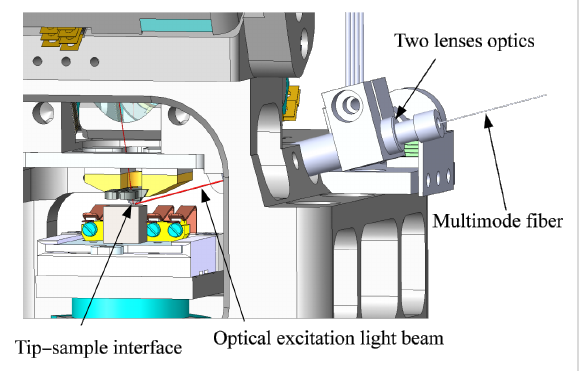
Figure 2: Additional two lenses optics which allows for the illumination of the tip–sample interface.